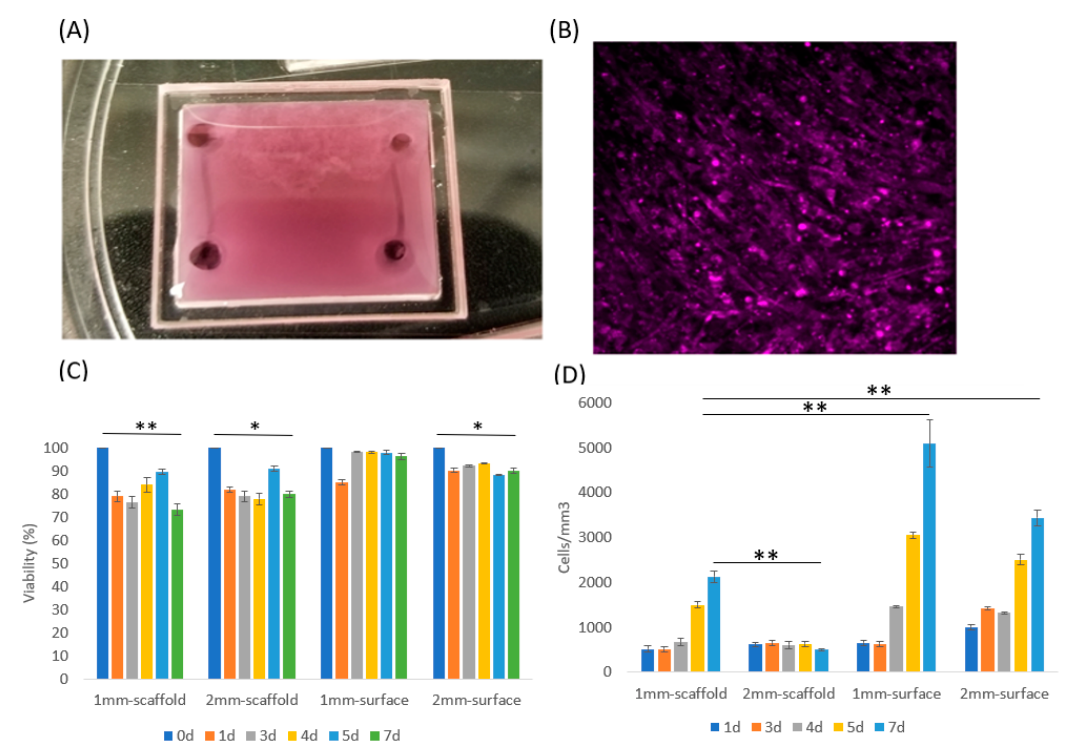
Figure 2. C2C12 culture in two and three dimensions. ( A ) The 3D ECM system with vascularized channels was made with a chamber made of a polymethyl methacrylate (PMMA) wall and coverslip. The chamber had dimensions of 17 × 19 × 2 mm. Two channels with D = 500 mm diameters were fabricated at both ends. ( B ) C2C12 cells were cultured on a 2D petri dish for 3 days with media and then the cells were stained with CellTracker DeepRed to examine cell viability. ( C ) Viability of 4 samples: Cells seeded in 1 mm thick collagen scaffold, 2 mm thick collagen scaffold, and cells cultured on the surface of 1 mm thick collagen and 2 mm thick collagen. Cell viability on 2.5D surface maintained higher than in 3D scaffold, according to Student T test. ( D ) The cell density of the 4 samples. Data were obtained by counting average cell numbers in each mm 3 volume in 3D or 2.5D. Error bar: SD from 3 repeats. Student T test (one tail) was applied to obtain statistical significance. *, p < 0.05; **, p < 0.01.